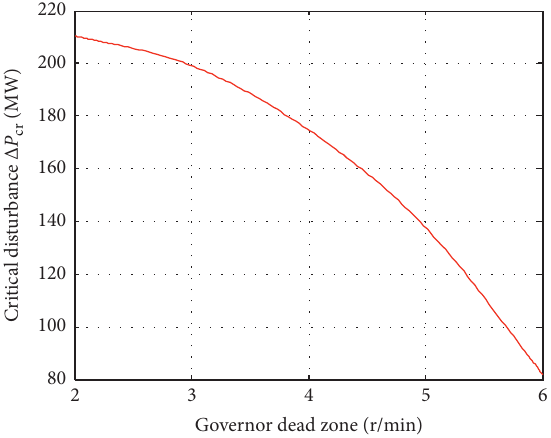
Figure 10: Critical disturbance amount curve after optimization of governor dead